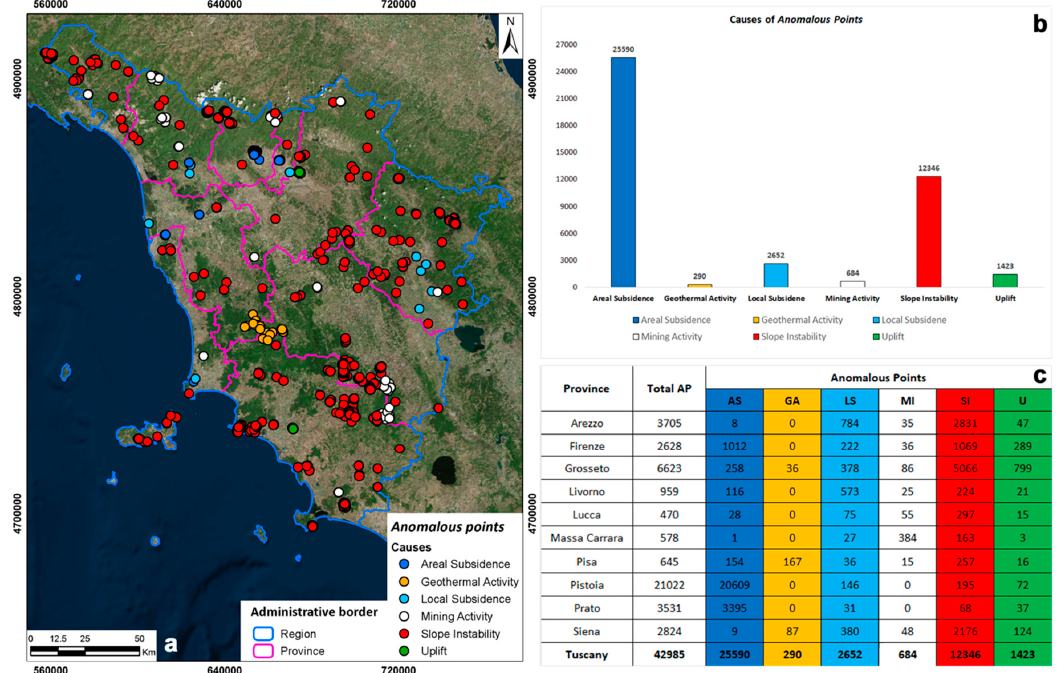
Figure 7. Classification of anomalous points according to the causes ( a ). On the right, an explanation of the presence of APs divided by causes for the entire region ( b ) and extrapolated for each province ( c ) (updated after [53]).